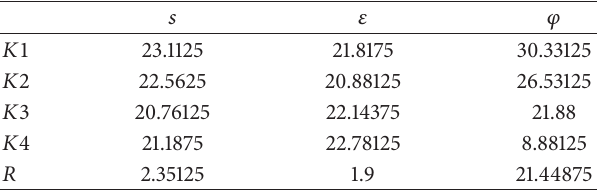
Table 3: 𝐾 and 𝑅 for propulsive force.